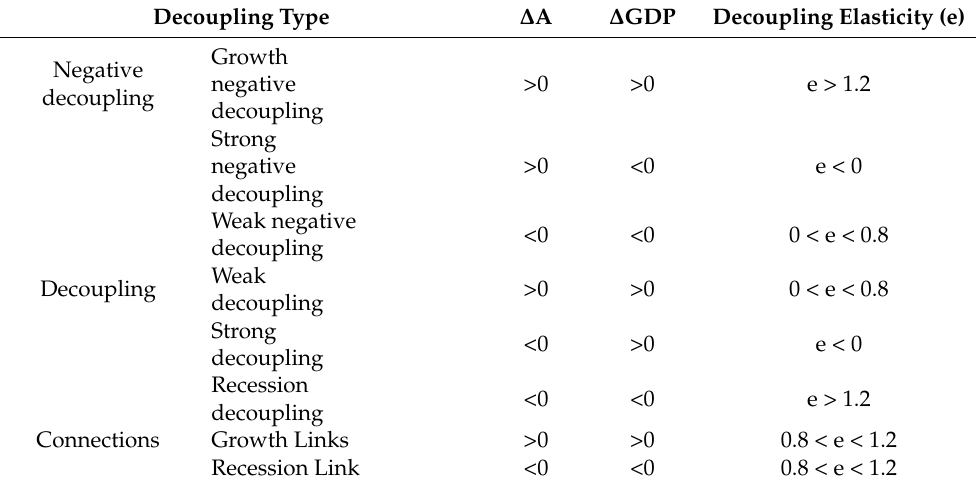
Table 1. Criteria for delineating the degree of decoupling between urban expansion and economic